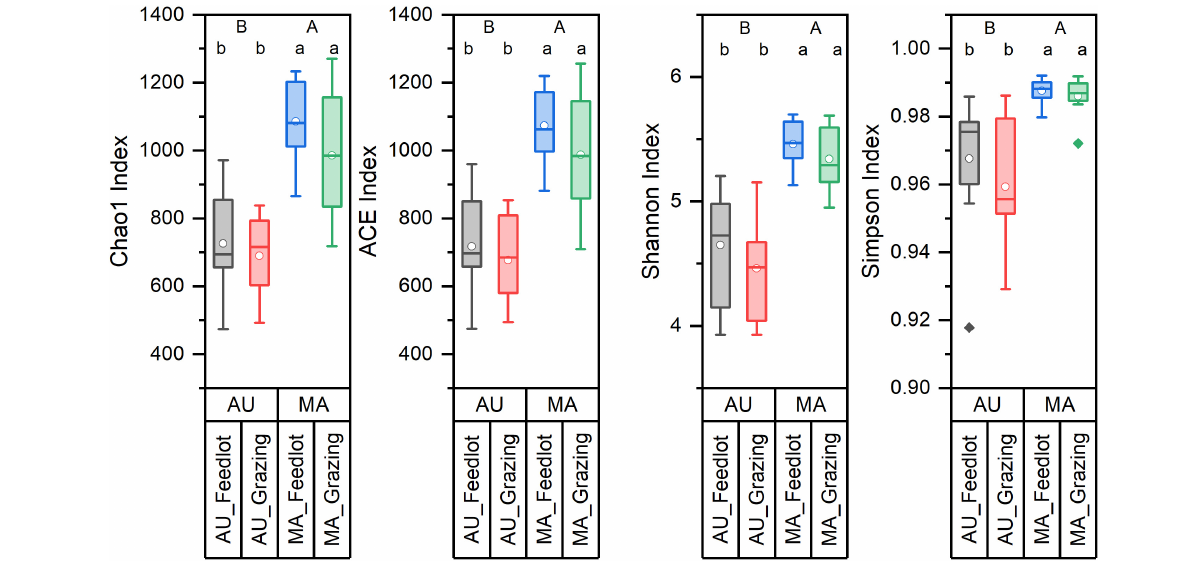
an observation confirmed by PERMANOVA ( R 2 = 0.28, p < 0.001). Furthermore, despite the diversity within the microbial communities in the two rearing systems not being different, a significant difference in the composition (i.e., in the structure) of the bacterial communities was observed for the rearing system